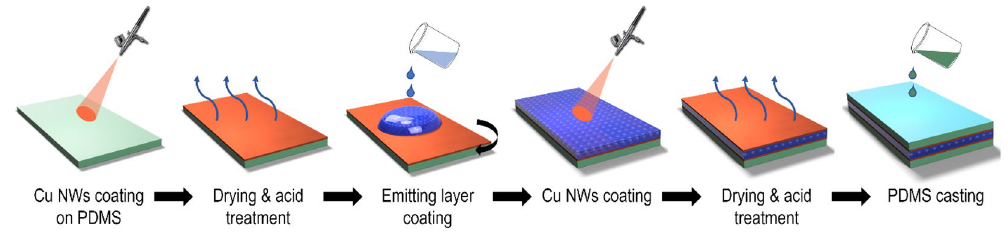
Figure 3. Schematic of the electroluminescent device fabrication